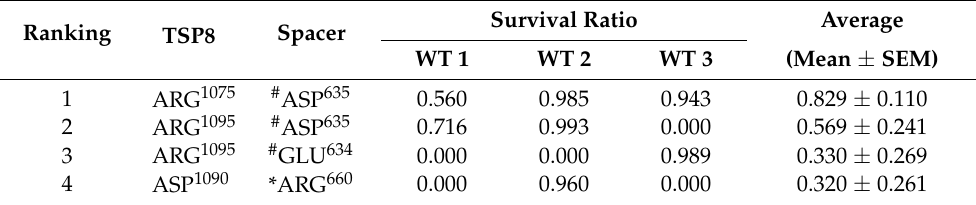
Table 4. The salt bridges on the interface of the WT TSP8-Spacer complex with an average survival ratio